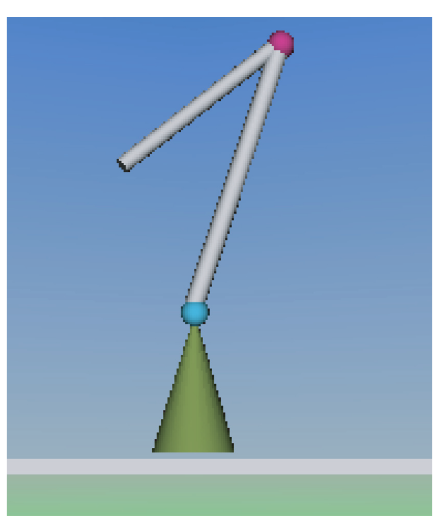
Figure 3: DIP system representation in V-Realm